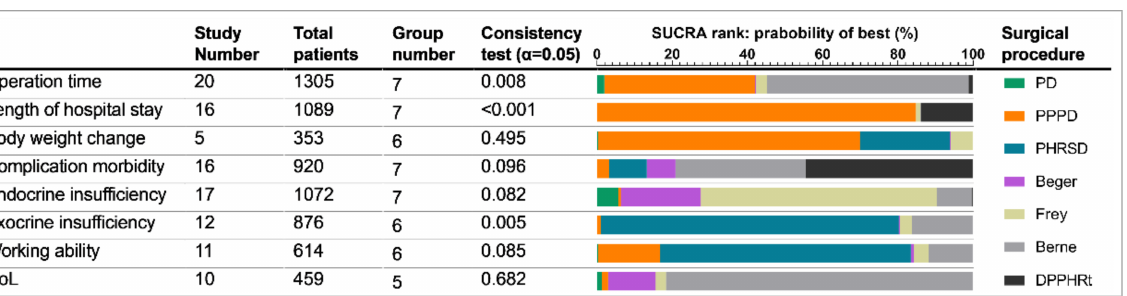
TABLE 3 Subgroups of network